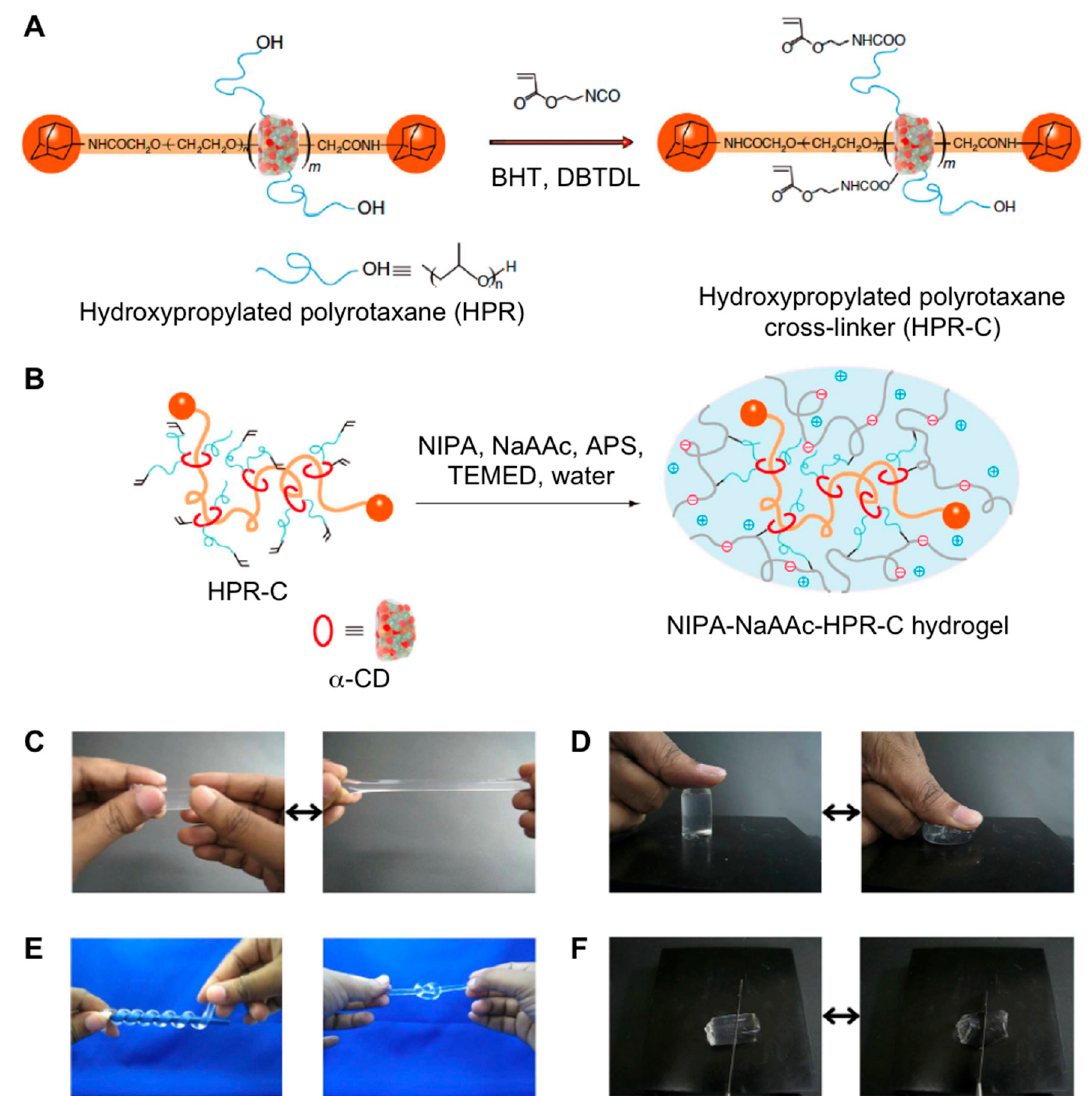
Figure 13. ( A ) Preparation of HPR-C from HPR, 2-acryloyloxyethyl isocyanate, dibutyltin dilaurate (DBTDL) (catalyst) and butyl hydroxyl toluene (BHT) (polymerization inhibitor) in DMSO. ( B ) Preparation of the NIPA-NaAAc-HPR-C hydrogel from HPR-C (cross-linker), NIPA (main monomer), NaAAc (comonomer), ammonium persulphate (APS) (initiator) and TEMED (accelerator) in water. ( C ) Elongated state of the NIPA-NaAAc-HPR-C hydrogel. ( D ) Compressed state of the NIPA-NaAAc-HPR-C hydrogel. ( E ) Coiled and knotted states of the NIPA-NaAAc-HPR-C hydrogel. ( F ) The NIPA-NaAAc-HPR-C hydrogel could not be easily cut with a knife. Adapted with